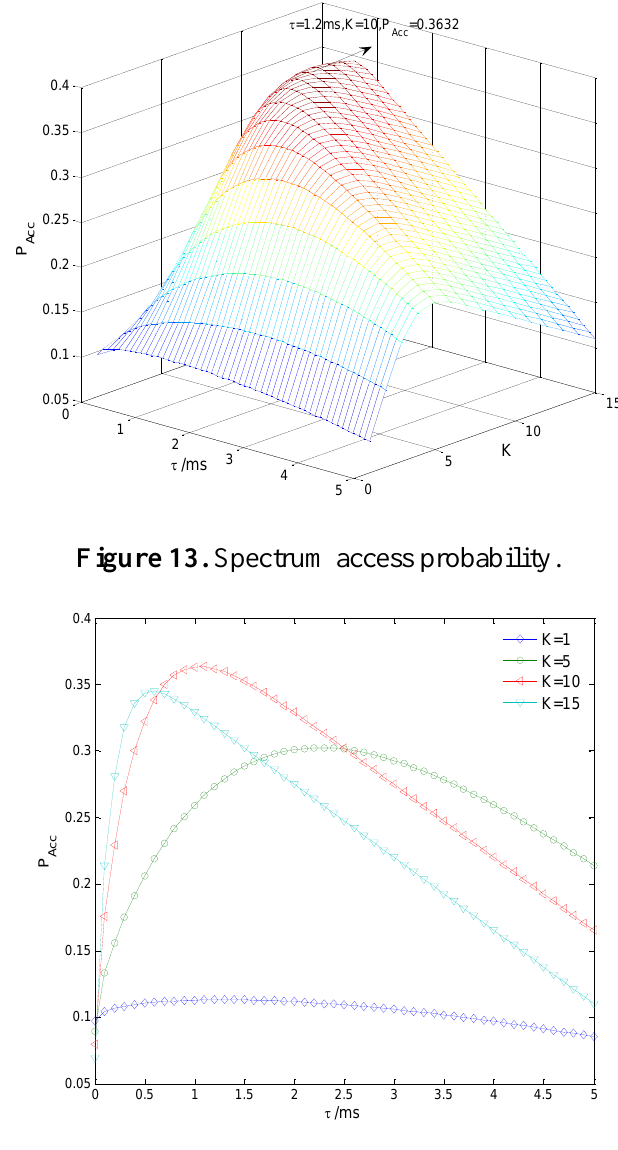
Figure 14. Spectrum access probability versus clustering